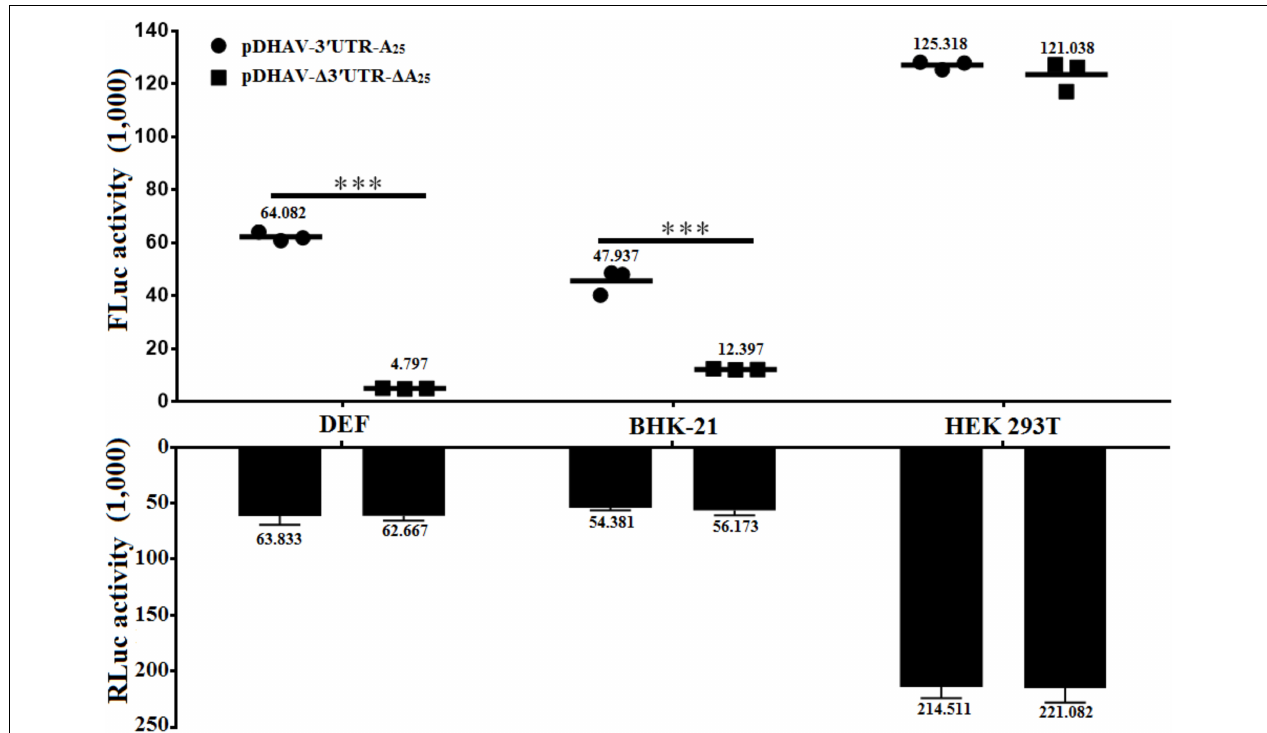
FIGURE 8 | Effects of 3 (cid:48) UTR plus poly(A) tail on IRES-mediated translation efficiency in various cell lines. Equal amount ( ∼ 2 × 10 5 ) of DEFs, or BHK-21, or HEK 293T were seeded into 24-well plate 12 h before transfection. 0.8 µ g of the Fluc activity of the pDHAV- (cid:49) 3 (cid:48) UTR- (cid:49) A 25 or pDHAV-3 (cid:48) UTR-A 25 were co-transfected into DEFs, BHK-21 cells, and HEK 293T cells with 0.1 µ g of pGMLR-TK plasmid to measure the FLuc/RLuc activity at 4 hpt. Data represent three replicate experiments for each group. ∗∗∗ P <